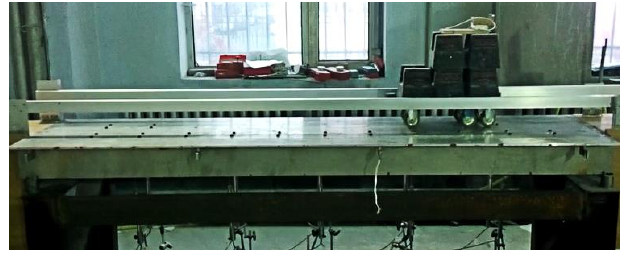
Figure 14. Photo of the entire experimental system of the model bridge.